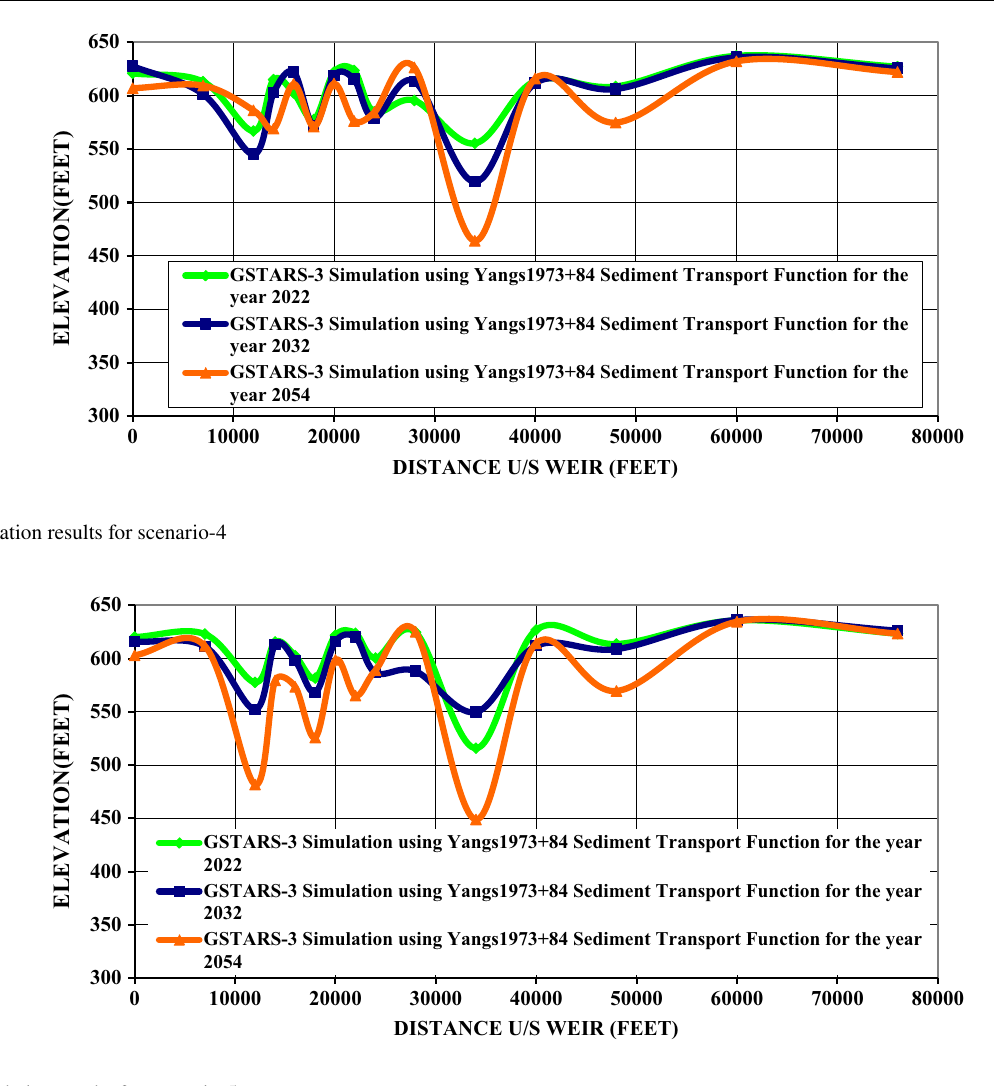
Fig. 10 Simulation results for